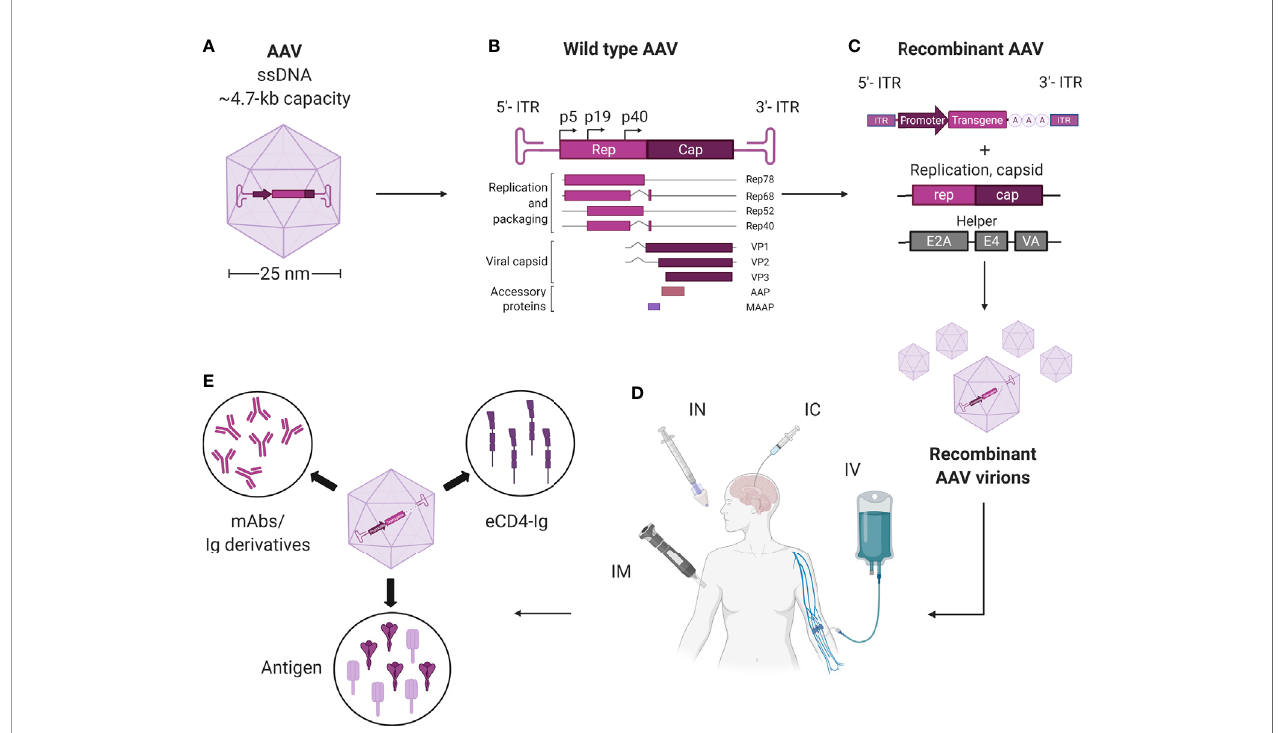
FIGURE 1 | Overview of AAV vectors harnessed for vectored immunoprophylaxis and therapeutics. (A) AAVs are small (~25 nm), non-enveloped viruses and have a 4.7-kb, single-stranded, linear DNA (ssDNA) genome encoding four open reading frames. (B) rep encodes the four genes required for genome replication (Rep78, Rep68, Rep52, and Rep40) and cap encodes the structural proteins of the viral capsid (VP1, VP2 and VP3). A third gene, which encodes assembly activating protein (AAP), is embedded within the cap coding sequence in a different reading frame and has been shown to promote virion assembly. The fourth ORF encodes for the recently discovered membrane associated accessory protein (MAAP). The role of MAAP is yet to be clearly de fi ned. (C) Providing rep and cap in trans enables a transgene of interest to be packaged inside the capsid to generate a replication-incompetent vector (recombinant AAV; rAAV). (D) rAAVs may be delivered via intramuscnular (IM), intranasal (IN), intracerebral (IC), and intravenous (IV) routes. (E) rAAVs expressing mAbs, eCD4-Ig and pathogenic antigens can be administered via different routes for therapeutics and immunization against infectious diseases. Created with